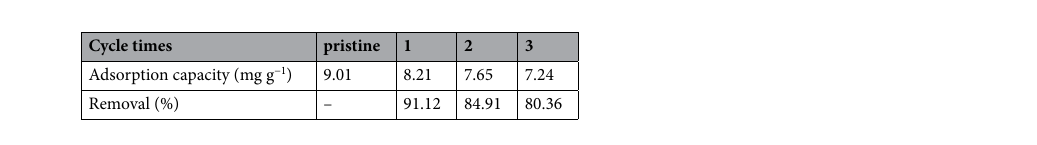
Table 6. The regeneration recycling experiment of